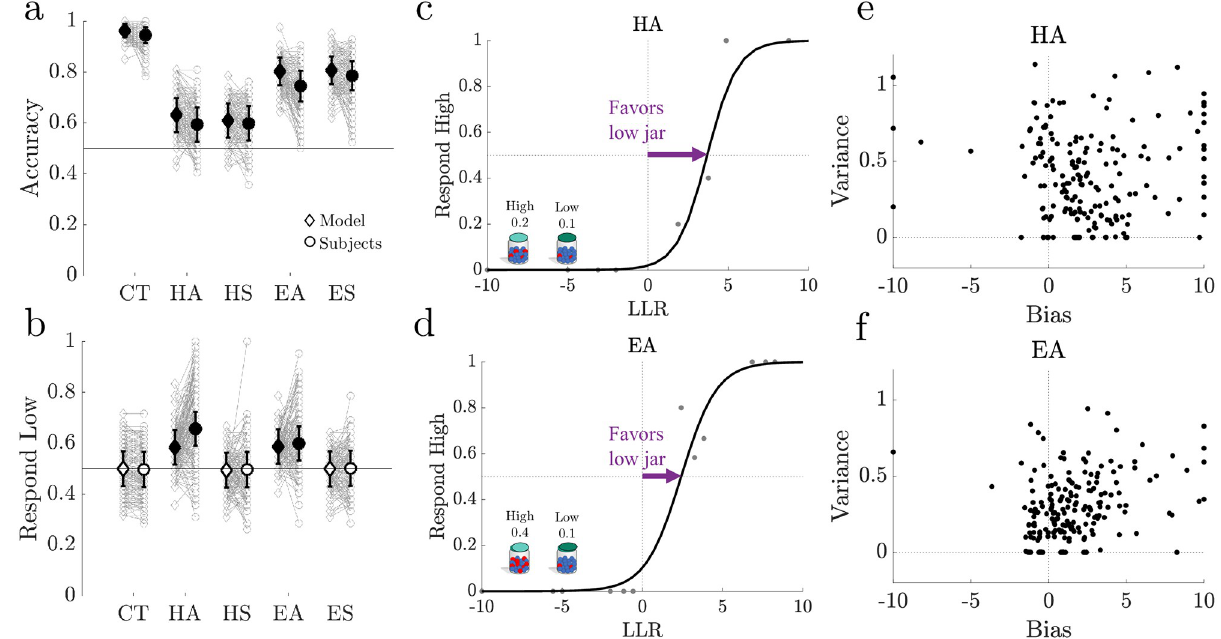
Fig 3. Human subjects displayed choice asymmetries that deviated from the ideal observer. a. Accuracy for each subject ( N = 198, grey circles) and sample-matched ideal observer responses (grey diamonds) for each block: Control (CT), Hard Asymmetric (HA), Hard Symmetric (HS), Easy Asymmetric (EA), Easy Symmetric (ES). Population bootstrapped means (1000 iterations) and 95% confidence intervals are shown in bold. Model and subject population accuracy was significantly above chance in all cases (0.5; p < 0.05). b. Low-jar response fractions displayed as in a . Filled markers denote a significant population shift away from the prior (0.5; p < 0.05). c-d. Example psychometric function (line) fit to a sample subject’s high-jar responses (dots) for the HA block ( c ) and EA block ( d ) across all sample lengths. e-f. Bias and variance for individual subjects (points) obtained from fits of the psychometric curves to data from HA blocks ( e ) and EA blocks ( f ). Bias was bounded between [ − 10, 10] to mitigate overfitting to outliers. Positive (negative) biases corresponded to more (fewer) low-jar selections.